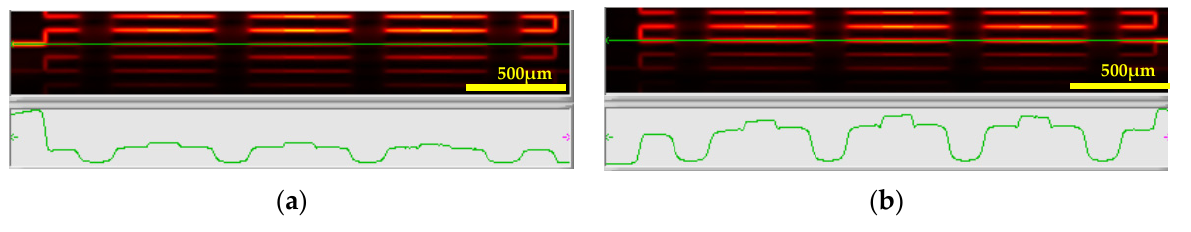
Figure 7. RF scan on reference sample at 43.0 MHz: ( a ) Left probe; ( b ) Right probe. Failed sample current density data were taken with both probes at the same time with two different frequencies, as shown in Figure 8. The signal decays in the same general area for both datasets along the green cursor. The red arrows point to that area of signal decay.